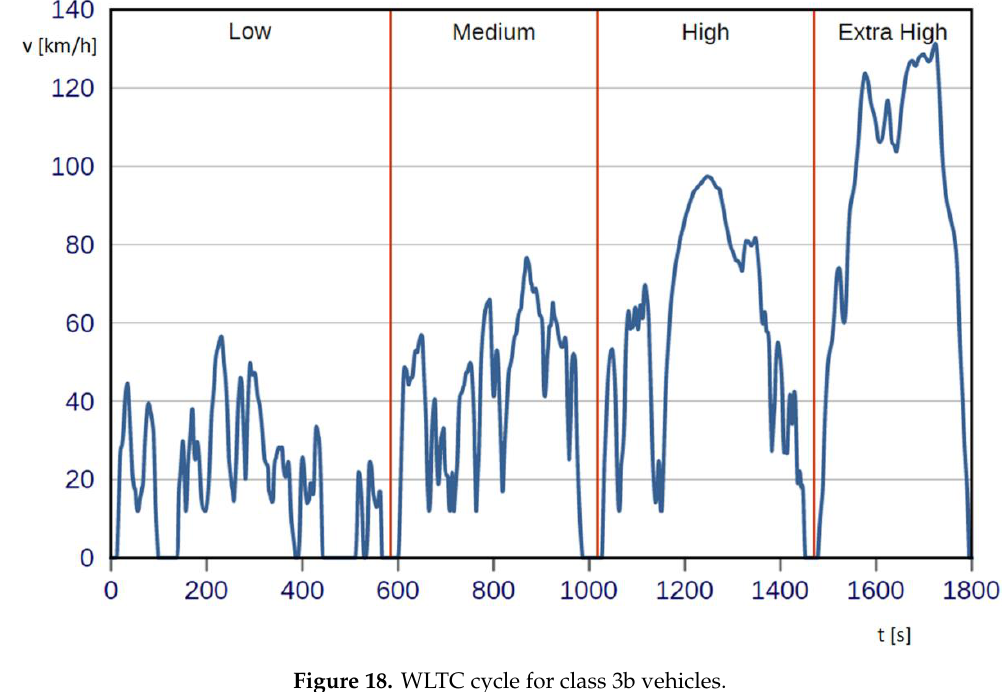
Figure 18. WLTC cycle for class 3b vehicles.